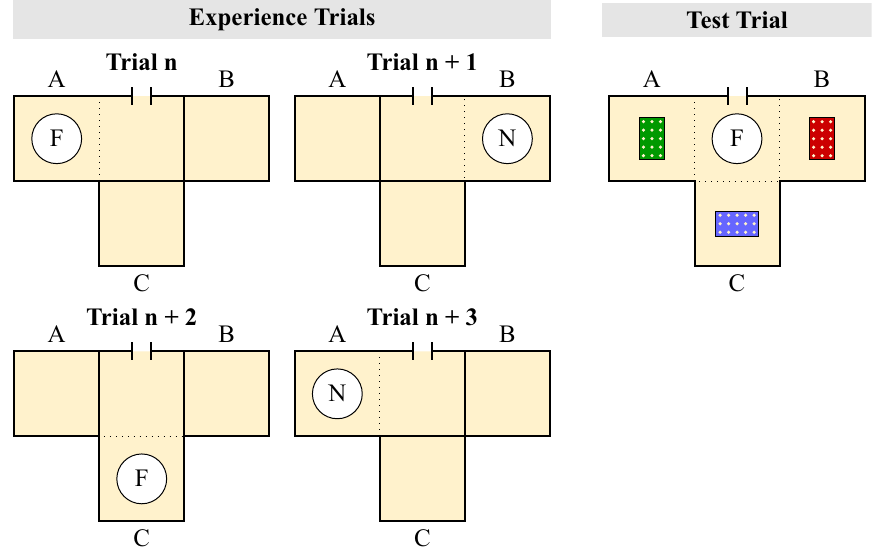
Figure 5. Top view of the experimental set-up of Experiment 2. Birds could access the three test compartments (A, B, C) from a middle compartment. On each experience trial (Left), the birds had access only to one test compartment (e.g., A in Trial n; B in Trial n+1), and they were presented either with a bowl containing powdered food (F, Trial n, Trial n+2) or with an empty bowl containing no food (N, Trial n+1, Trial n+3). The compartment that was accessible and food availability rotated on a 3-day cycle and on a 2-day cycle, respectively. On the test trial (Right), a bowl containing food items (i.e., not food in powdered form) was placed in the middle compartment and caching trays were placed in all test compartment. Birds could freely move and cache in all